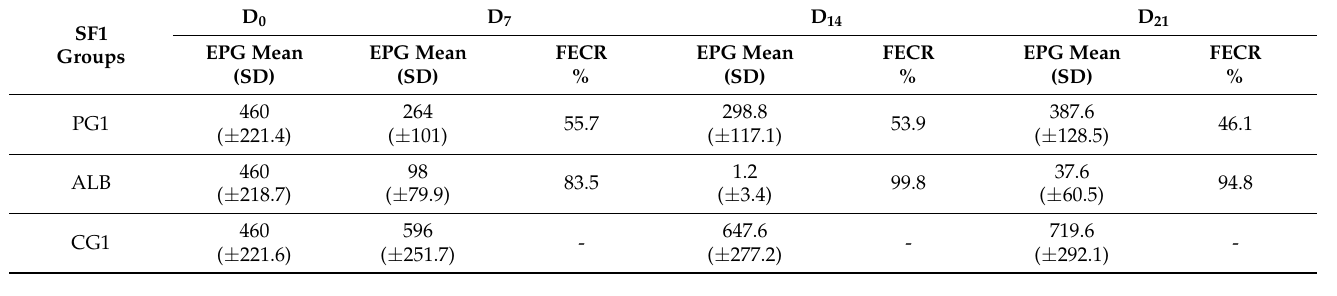
Table 1. Sheep farm 1 (SF1): results concerning the comparison between the anthelmintic efficacy of the aqueous P. granatum macerate with Albendazole. PG1: treated aqueous P. granatum macerate group 1 (50/mL/OS as a single dose); ALB: treated Albendazole group (3.75 mg/Kg/BW/OS as a single dose); CG1: untreated control group 1; gastrointestinal nematodes (GINs) eggs per gram (EPG) of faeces (mean) of the different groups and the faecal egg count reduction (FECR) (%) at different days (D) after treatment; SD (standard deviation).